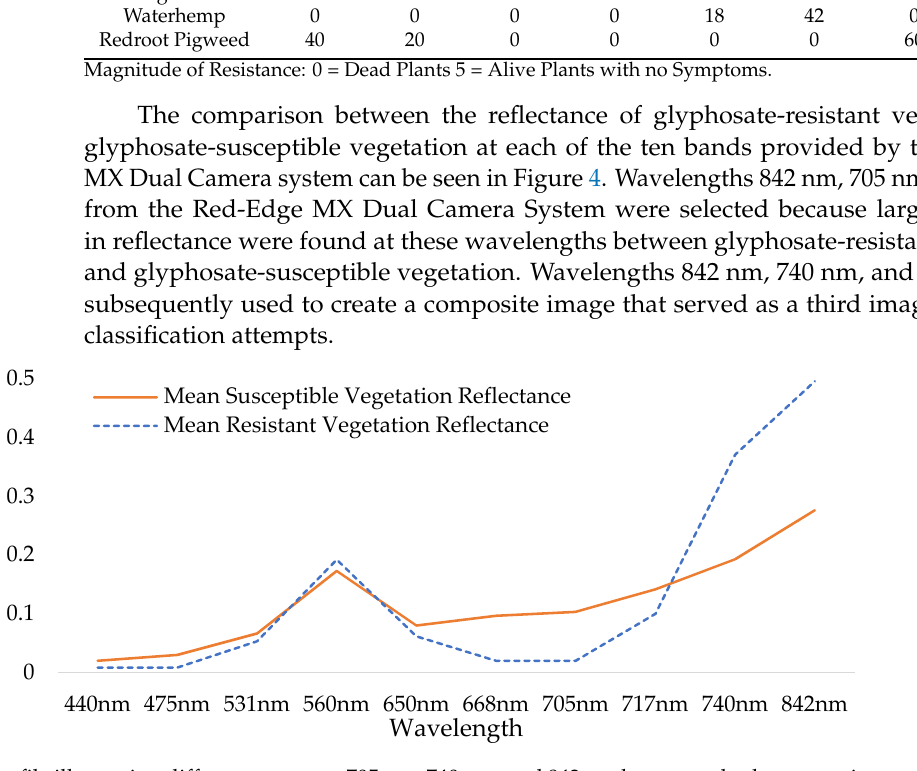
Figure 4. Spectral profile illustrating differences seen at 705 nm, 740 nm, and 842 nm between glyphosate-resistant vegetation and glyphosate-susceptible vegetation within the scene. A subset of the experiment datasets from the Casselton and Carrington locations at six days after glyphosate application are viewable in Figures 5 and 6. Similar image da- tasets from every collection period and location were used throughout the experiment.